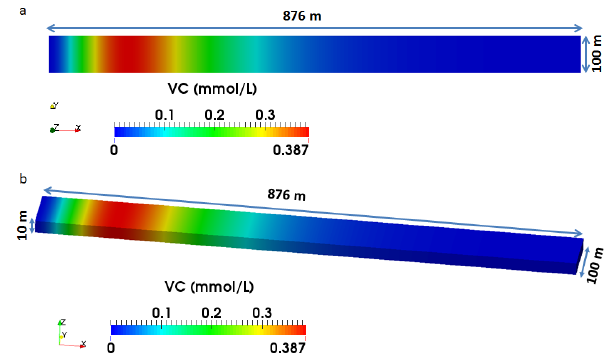
Figure 7. Concentration profile of light isotope VC of the 2-D model (a) and the 3-D model (b) at the end of the simulation. For (b) a 2-fold vertical ( z direction) exaggeration is